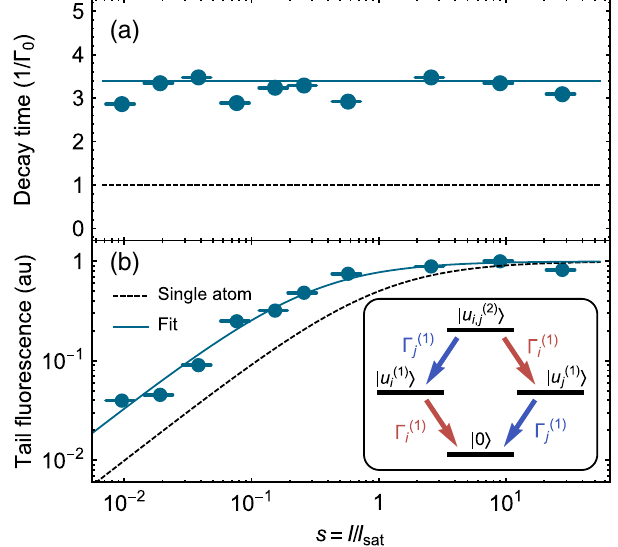
FIG. 3. (a) Measurement of the decay time of the subradiant tail (unit of Γ − 1 0 ) as a function of the saturation parameter s of the excitation laser. Black dashed line: single-atom decay time. (b) Total number of counts recorded in the subradiant tail (normalized to the maximum value) as a function of s , together with a fit by a function α s= ð 1 þ α s Þ (blue solid line). From the fit, we extract a decay time τ ¼ α Γ − 1 0 (see text), which is shown as a solid blue line in panel (a). Black dashed line: single-atom response obtained by setting α ¼ 1 in the previous equation. Inset: independent decay process of multiply excited subradiant ¼ 2 ). Singly excited states states (here, exemplified with n exc decay independently at a rate given by decay rates of the single- excitation subradiant